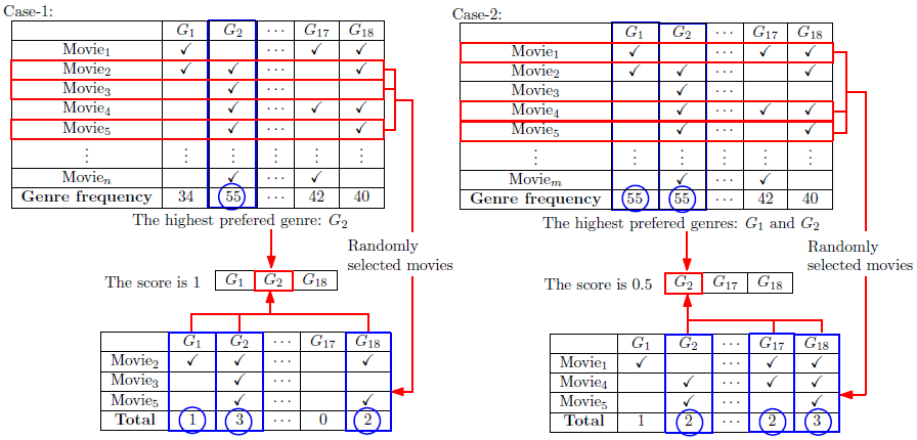
Figure 32. Example of calculating the score using Equation (3).